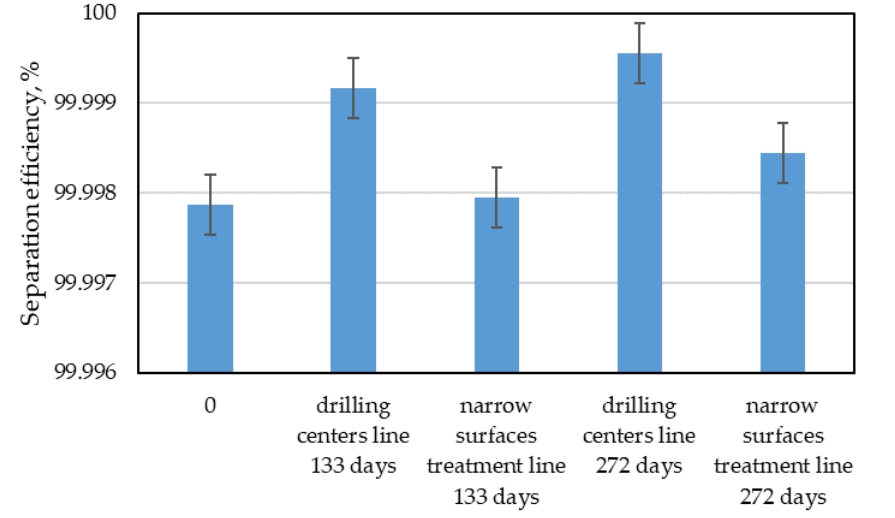
Figure 9. Total separation efficiency for all installations.